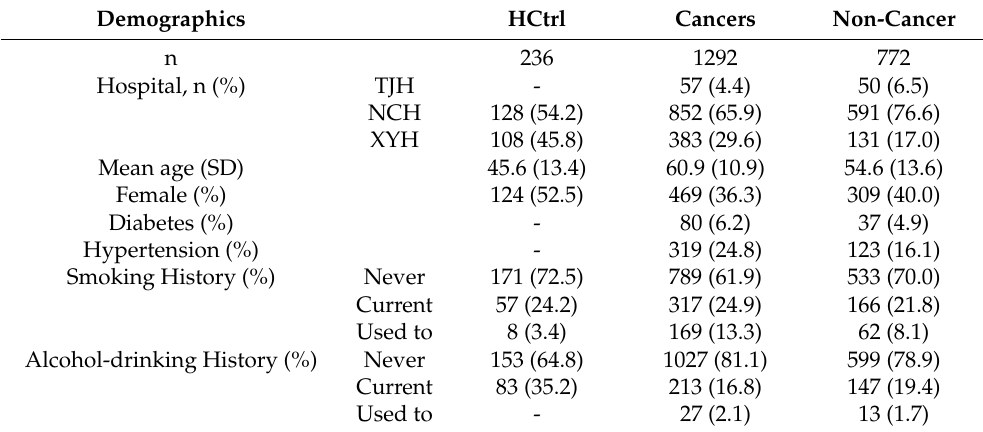
Table 2. The demographics of the cohort